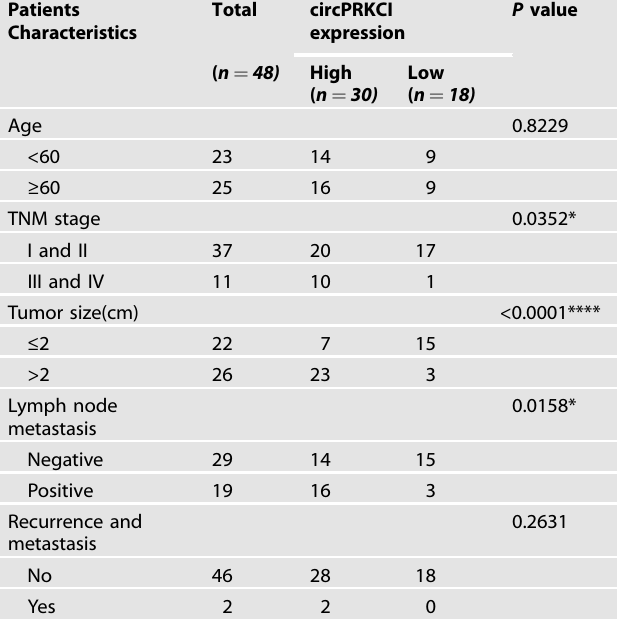
Table 1. The relationship between the expression of circPRKCI and various clinicopathological variables in BC patients. Patients